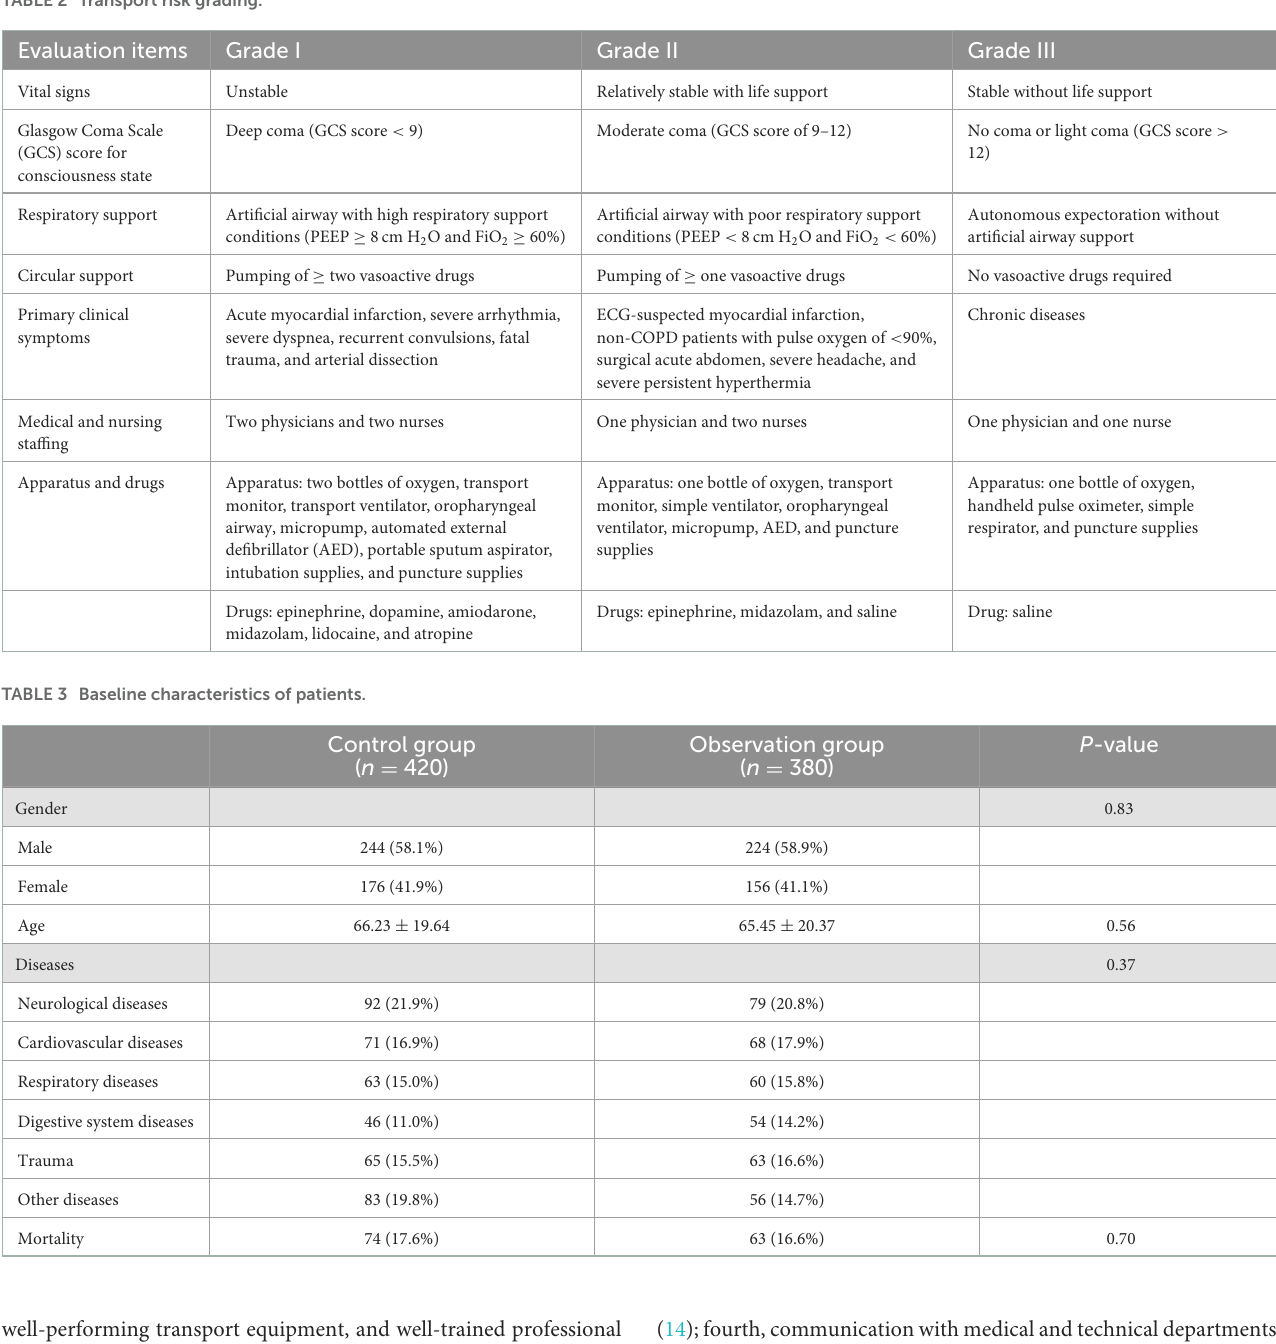
TABLE 2 Transport risk grading.